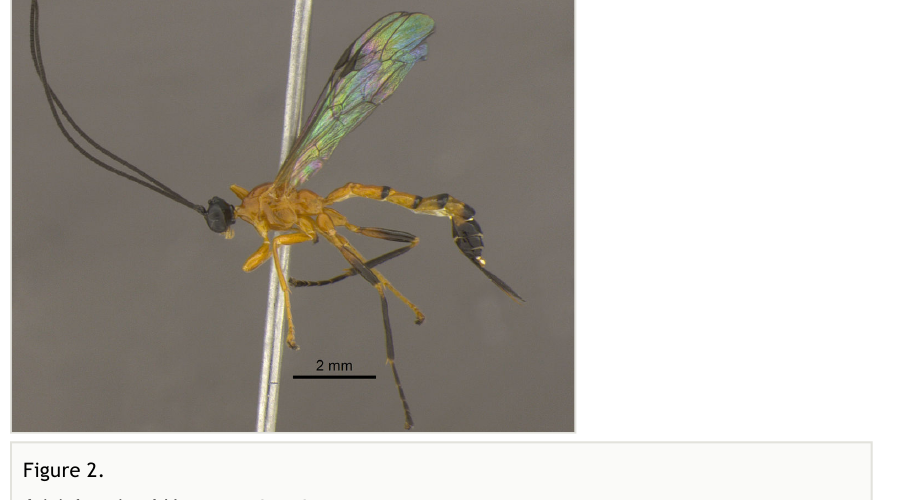
The female and male of H. manauara were recently described by Pádua et al. (2015) and were characterized by having the femur orange with black apex. However, the female in our study (Fig. 2) showed an intraspeci fi c variation: femur orange with a half-black apex.